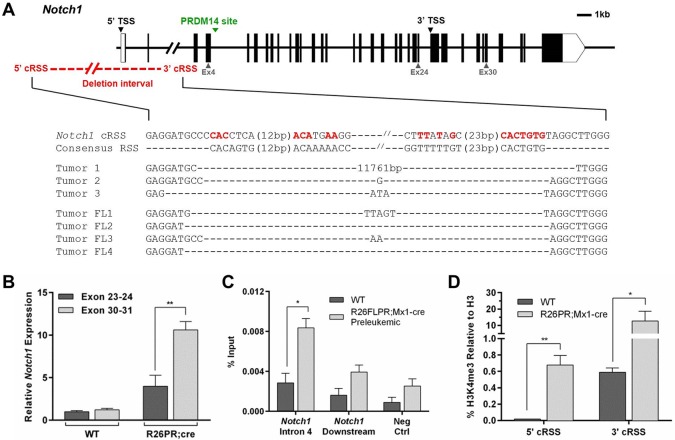
Notch1 is mutated and bears focal epigenetic changes in PRDM14-expressing cells. (A) Upper, schematic of the Notch1 locus. Exons are shown as black boxes. The region deleted in PRDM14-induced tumors, the canonical transcription start site (5′ TSS), the downstream 3′ TSS, and the putative PRDM14 binding site are indicated. Lower, alignment of sequences from PRDM14-induced tumors with the consensus RSS and cryptic RSS (cRSS) found at Notch1. Conserved nucleotides are shown in red. (B) Ratiometric qRT-PCR using primers spanning Notch1 exon 23-24 and Notch1 exon 30-31 in wild-type (WT) (n=5) and R26PR;cre (n=7) thymi. Values shown are relative to one wild-type animal. (C) ChIP-qPCR for FLAG-PRDM14 at the putative PRDM14 binding site in Notch1 intron 4, a non-specific intronic site 2.5 kb downstream of the putative Notch1 binding site, and a gene desert located on Chr 6 that contains no genes (Neg Ctrl) in unsorted whole bone marrow of wild-type (n=3) and R26FLPR;Mx1-cre (n=3) mice at 10 days post-pIpC injection. (D) ChIP-qPCR for H3K4me3 at the Notch1 5′ and 3′ cRSSs in wild-type (n=5) and R26PR;Mx1-cre (n=5) thymi. Mean±s.d. shown for all graphs. *P≤0.05, **P≤0.01.